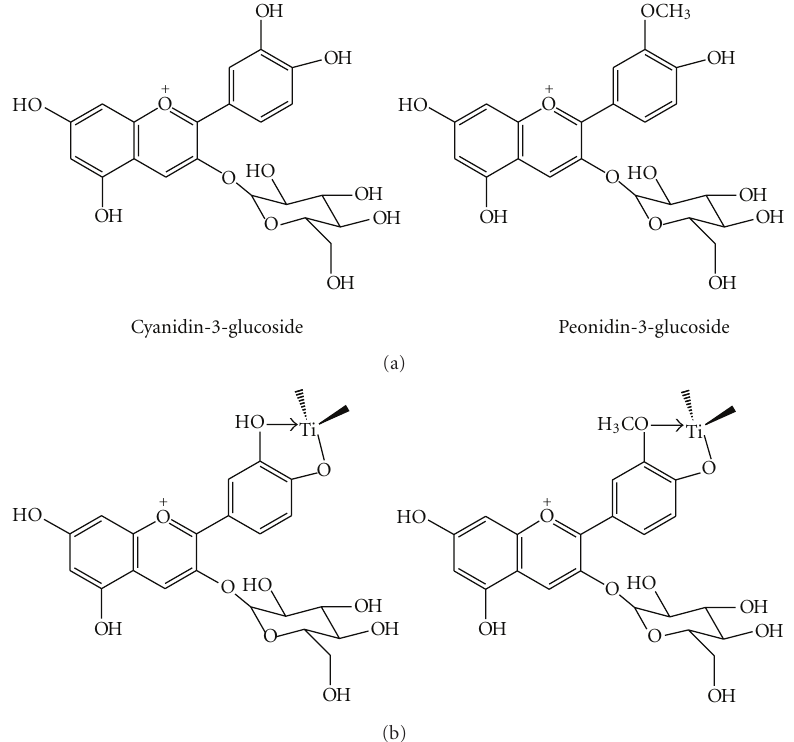
Figure 2: (a) Chemical structure of cyanidin-3-glucoside and peonidin-3-glucoside present in black rice. (b) The binding between anthocyanin molecule and TiO 2 particle.